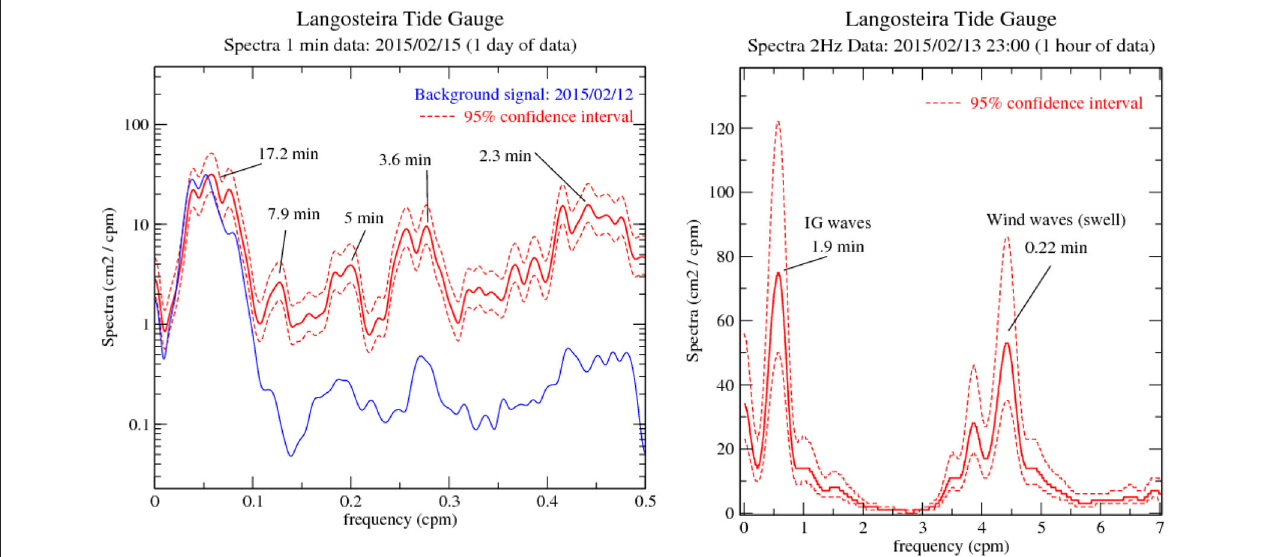
FIGURE 13 | Left: spectral analysis of 1min (left) and 2Hz (right) data for Langosteira tide gauge on February 13th 2015. The 1-min and 2Hz data have been high-pass filtered (periods < 3h and periods < 45min respectively). Red lines: spectra for 1day/hour of maximum sea level oscillations (and 95% confidence intervals). Spectra from the background signal was added to the 1-min spectra (blue line) and a logarithmic vertical scale used in this case for easier comparison of the peaks: the energy at higher frequencies (e.g., periods of 3.6 and 2.3min) increase significantly during this event. The 2Hz spectrum reveals the energy content on the infragravity waves (peak very close to the Nyquist frequency of 1min data) and on the swell bands. Spectra method: auto-covariance function smoothed with a Parzen lag window (40 degrees of freedom).